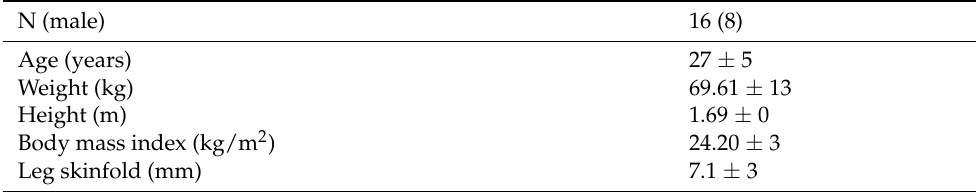
Table 1. Baseline characteristics of the